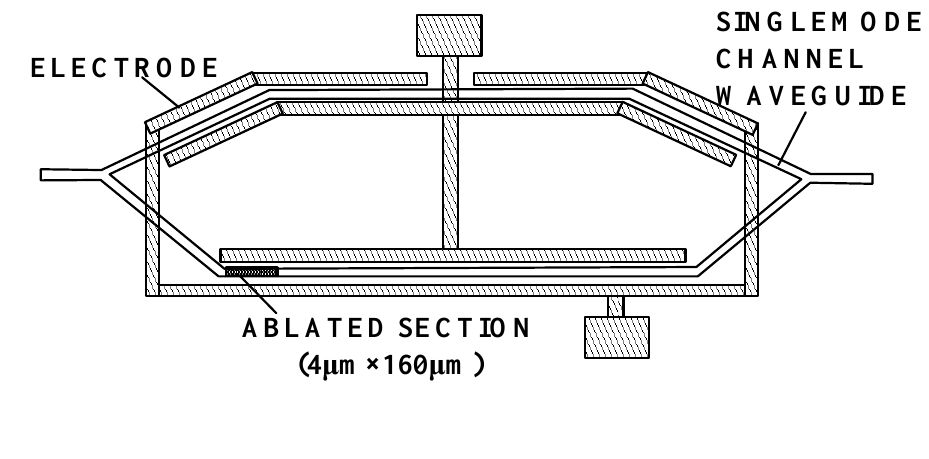
is adjusted by laser ablation [51] B